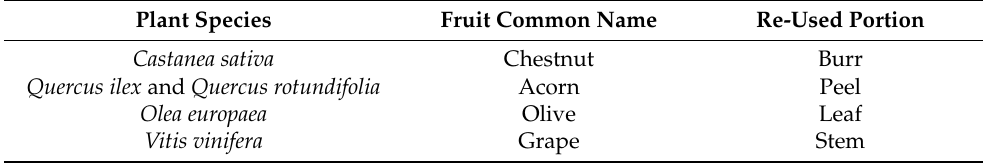
Table 2. Plant-based coagulants sources: plant species, fruit common name, and re-used portion. Plant Species Fruit Common Name Re-Used Portion Castanea sativa Chestnut Burr Quercus ilex and Quercus rotundifolia Acorn Peel Olive Leaf